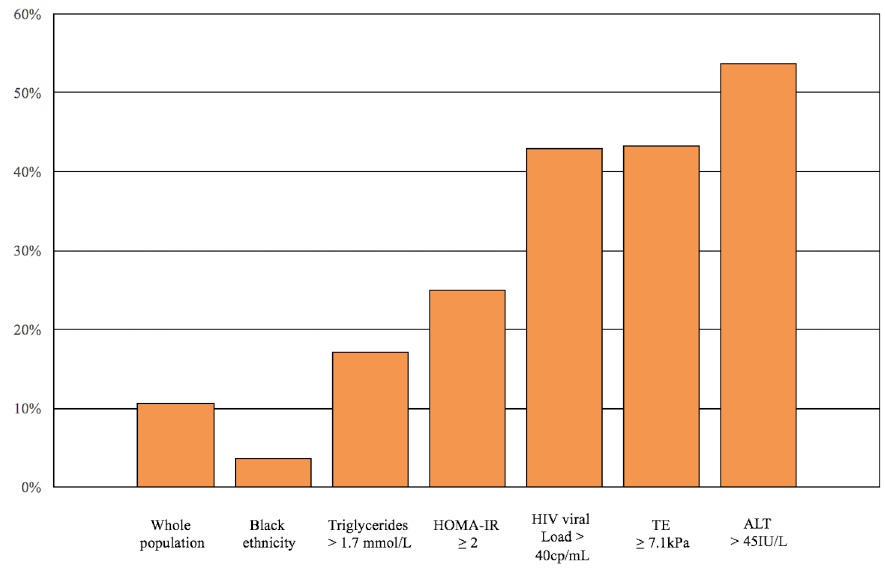
Fig 2. Prevalence of NASH (CAP (cid:21) 248 dB/m and CK-18 > 246 U/L) according to patients’ characteristics.